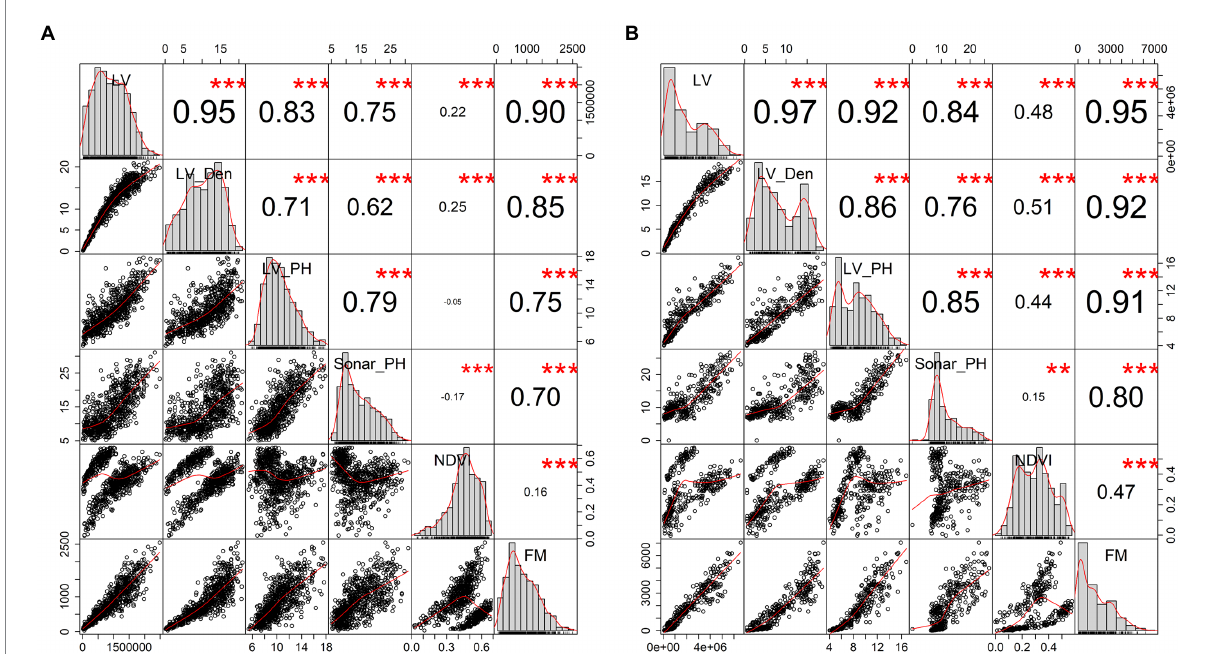
FIGURE 3 Evaluation of the relationships between plant digital parameters extracted from sensor-based phenomics and harvested fresh biomass (FM) in the combined seasonal dataset. Panel (A) presents 720 samples at row level and panel (B) for 368 samples at the plot level. In the panel, histogram windows display the distribution of individual parameters on the diagonal of the panel, whereas the bivariate scatter plots with a red fitted line and Pearson’s correlation coefficient with the significant level as stars at the top and bottom of the diagonal, respectively. Star symbols are “***,” “**” and “*” for p-values are ≤ 0.001, 0.01, and 1.0. LV, LiDAR plant volume; LV_Den, LiDAR point density; LV_PH, LiDAR plant height; Sonar_PH, ultrasonic plant height; NDVI, multispectral normalized different index; and FM, manual harvested fresh biomass.